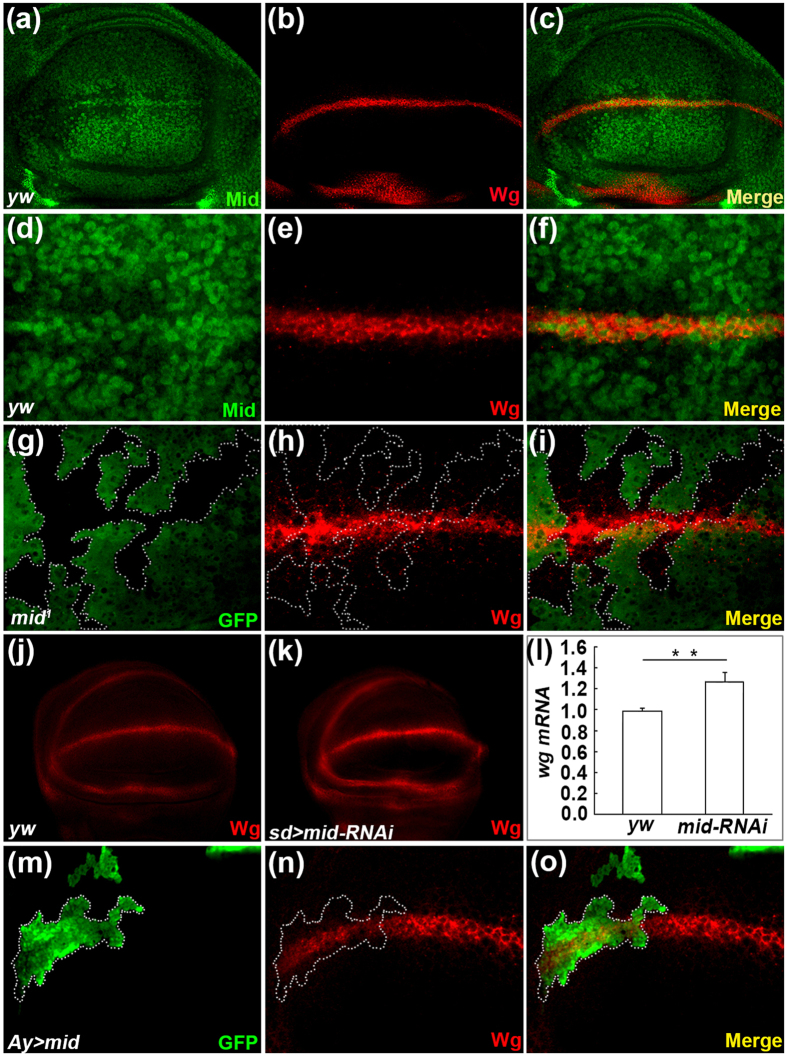
Mid represses the expression of wg.(a–c) The expression of Mid (a) and Wg (b) in the wild-type wing disc. (c) Merged image of (a,b). (d–f) Magnified images of the partial region in (a–c) are shown. (g–i) Wg expression is activated in a mid mutant clone (mutant clone lack GFP signal and marked by a broken line) induced in the DP cells of the wing disc. The wing disc from a third instar larva of hs-FLP; FRT42D, Ubi-GFP/FRT42D, mid1 is stained with anti-GFP antibody (g), anti-Wg antibody (h). (i) Merged image of (g,h). (j,k) Activation of the Wg expression in the wing disc of sd-Gal4; UAS-mid-RNAi (k) compared with that of yw (j). (l) qPCR analyses of the wg mRNA level between yw and sd > mid-RNAi. Error bar, SEM from three independent experiments. Student’s tests, **p < 0.01. (m–o) Somatic clone overexpressing Mid display downregulation of Wg (clone with GFP signal is marked by broken line). The wing disc from a third instar larva of hs-FLP; UAS-mid/act > y + > gal4; UAS-GFP is stained with anti-GFP antibody (m), anti-Wg antibody (n). (o) Merged image of (m,n).